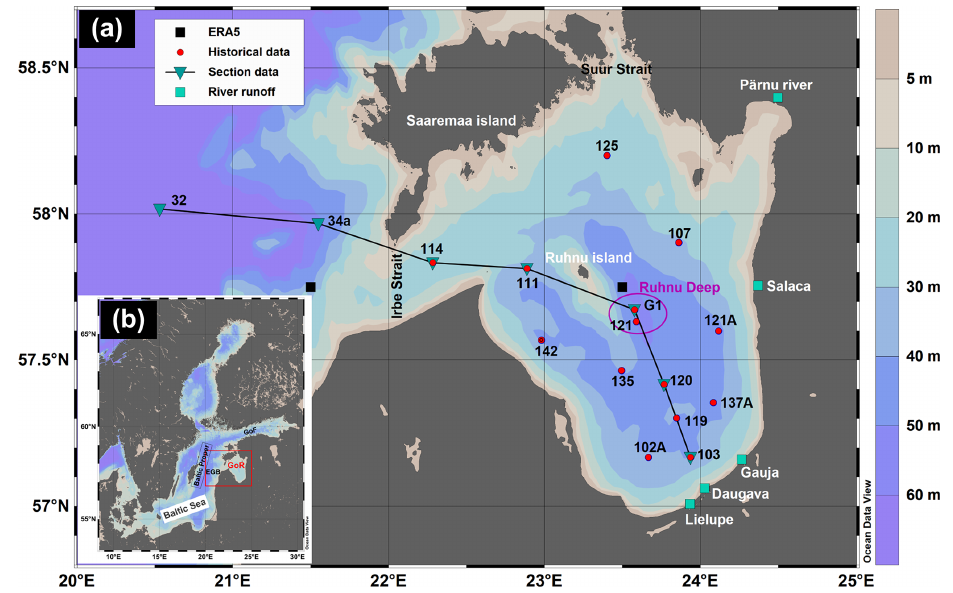
Figure 1. (a) – Map of the study area in the Gulf of Riga (GoR) with bottom topography. Red-filled circles represent the locations of monitoring stations. Inverted triangles represent the stations used for section figures. Black-filled squares represent the grid cell center points of ERA5 data (grid cell resolution 0.25 ◦ × 0.25 ◦ ). Green-filled squares denote rivers from which runoff data were used. EGB – Eastern Gotland Basin and GoF – Gulf of Finland. (b) Study area in the Baltic Sea. This map was generated using Ocean Data View 5.2.0 software (Schlitzer,